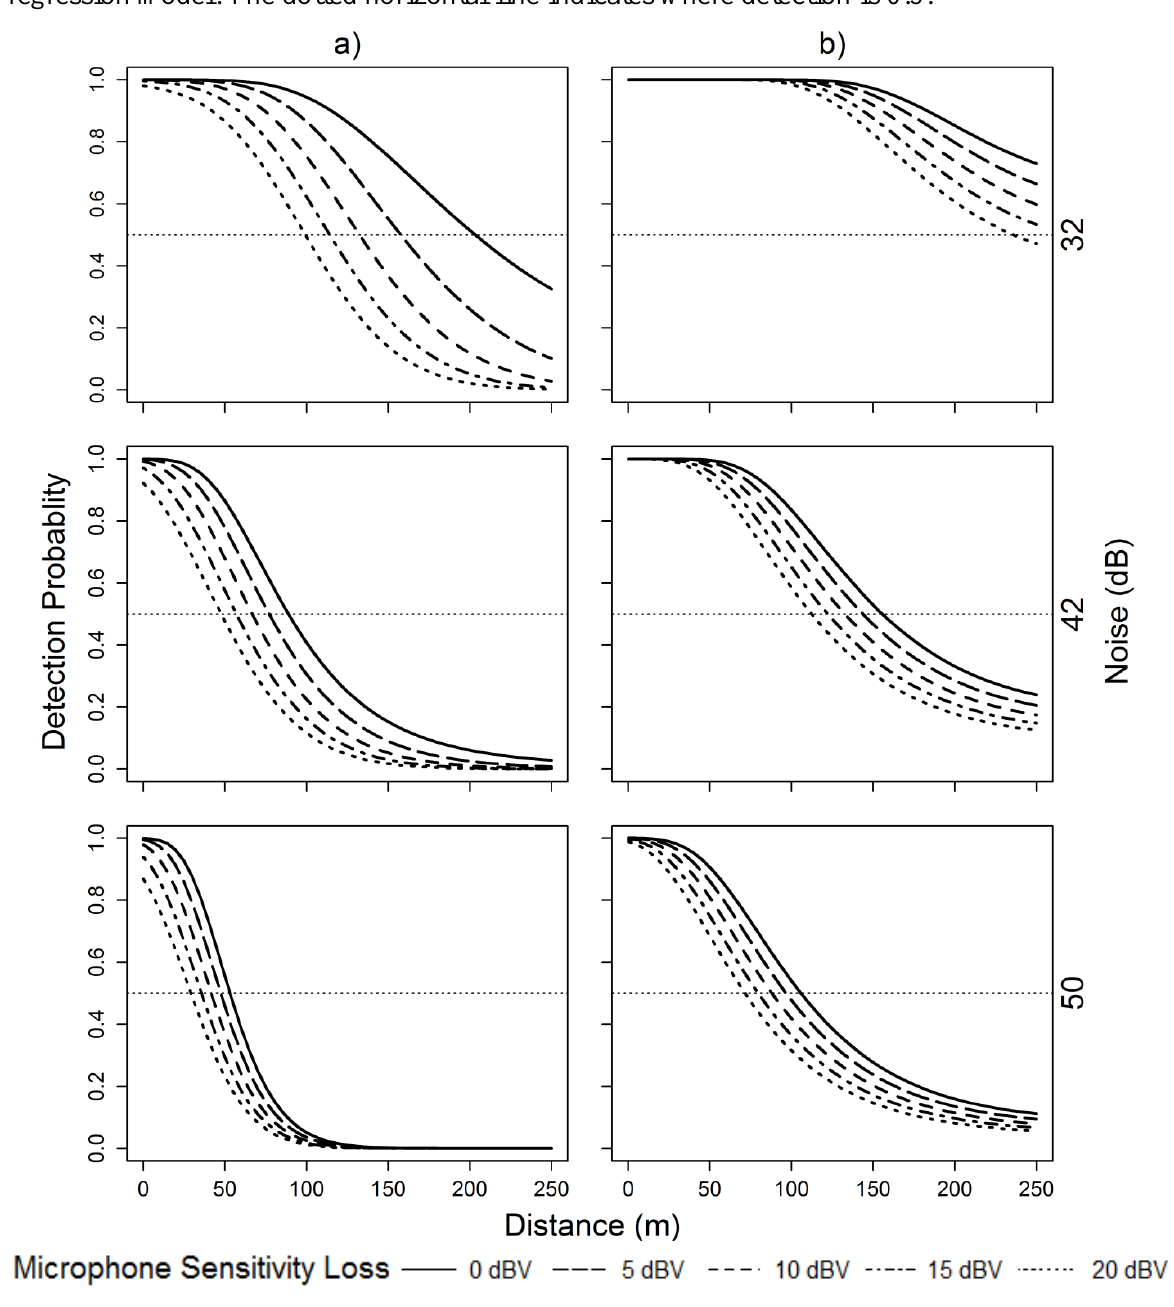
Figure A4.3. Detection probabilities of a) Yellow Rail and b) Ovenbird for five levels of microphone sensitivity loss and under three noise conditions based on selected binomial regression model. The dotted horizontal line indicates where detection is